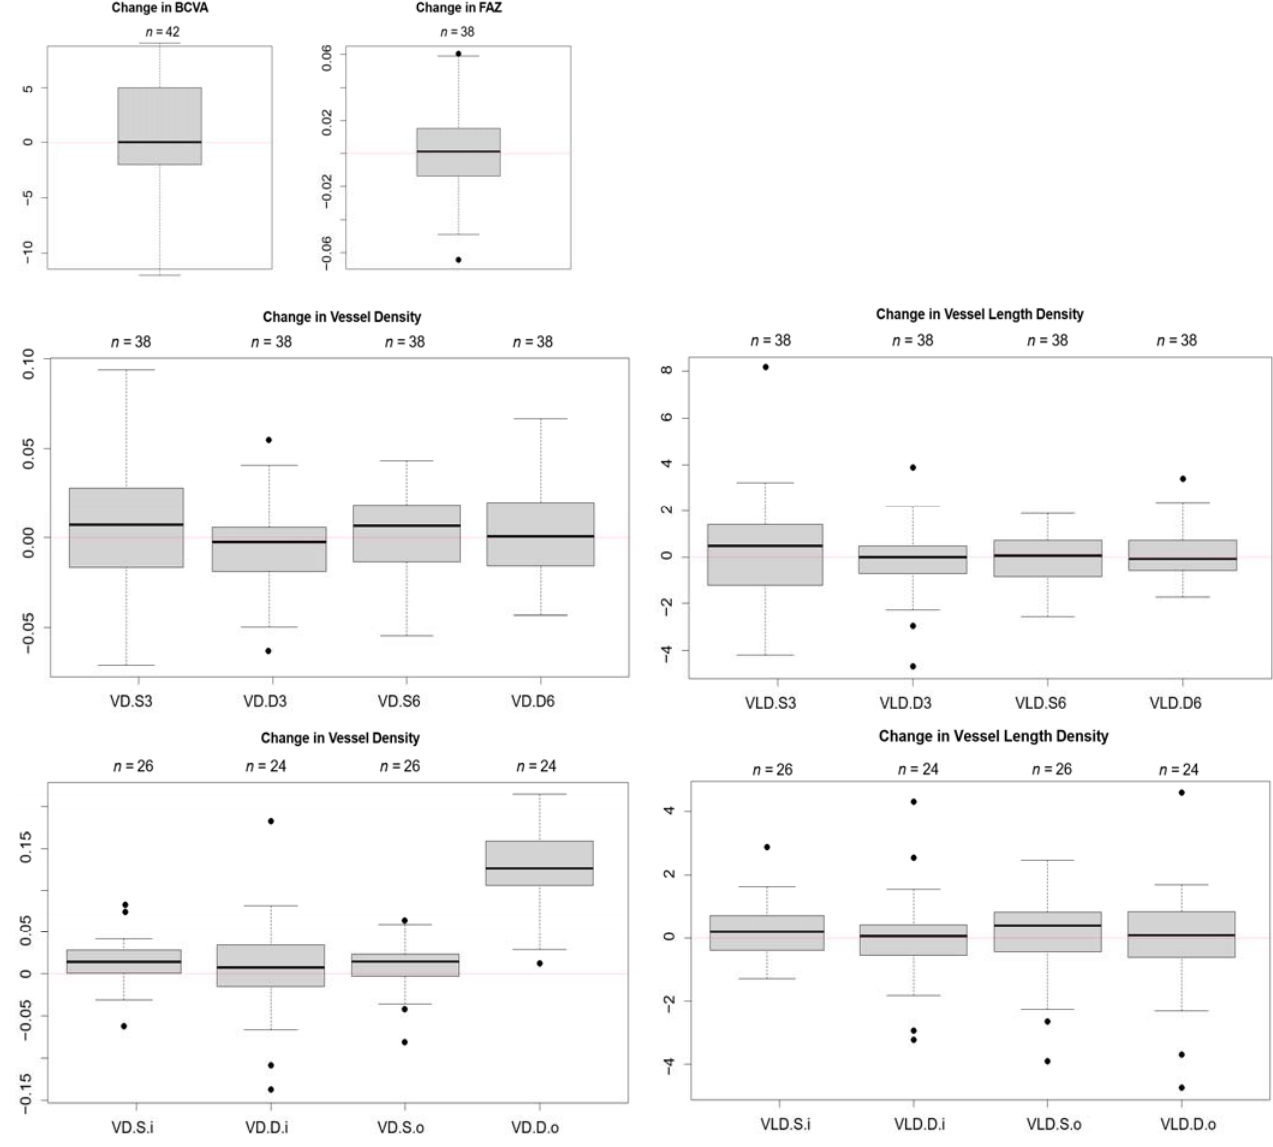
Figure 3. Quantitative analysis of OCTA: Change in measurements (pre ‐ and post ‐ TAVI) of vessel density and vessel length density of the superficial and deep plexus did not show a statistically significant difference, the values oscillate around zero. n gives the number of eyes included for the specific quantitative analysis (with sufficient image quality at baseline and post ‐ TAVI). BCVA = best corrected visual acuity. FAZ = foveal avascular zone. VD = vessel density. VLD = vessel length density. S = superficial plexus. D = deep plexus. 3 = macula 3 × 3 mm scan size, 6 = macula 6 × 6 mm scan size. i = papillary inner ring scan. o = outer papillary ring scan.